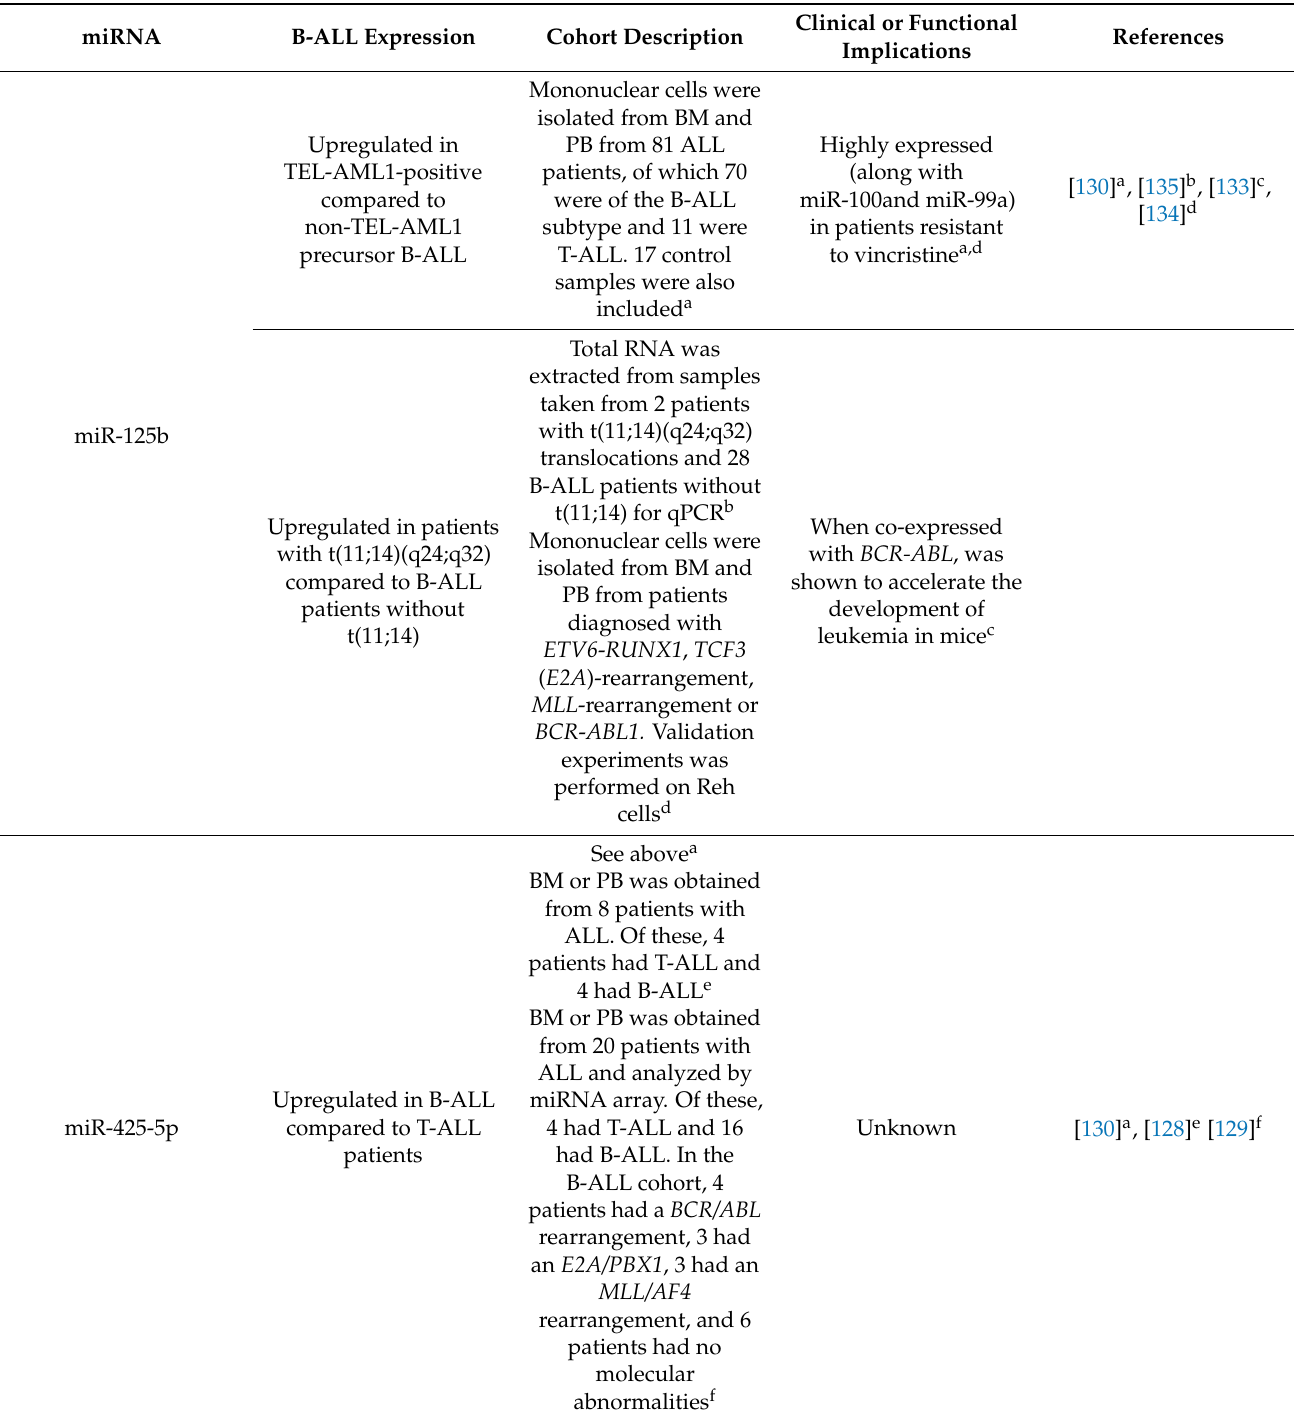
Table 2. Examples of microRNAs with significance in B-cell acute lymphoblastic leukemia.